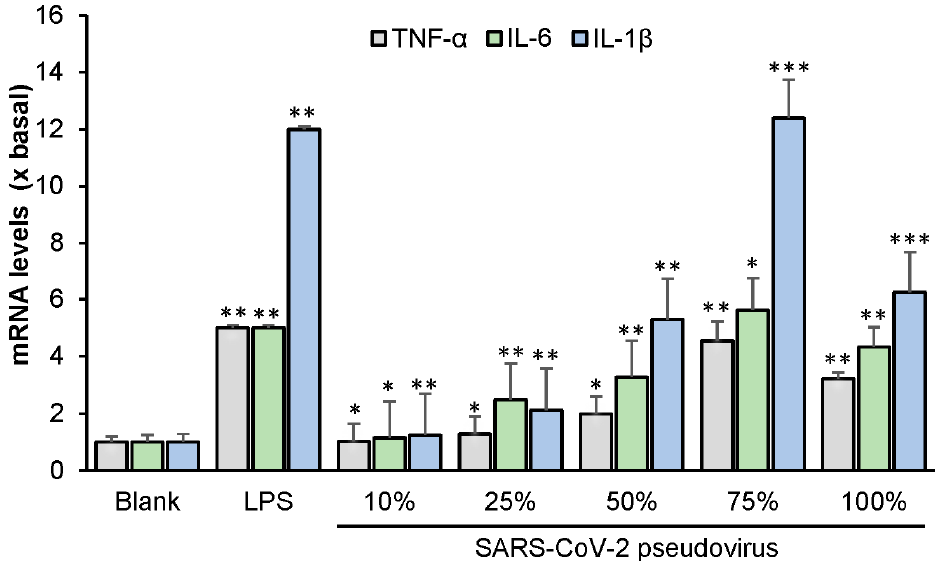
Figure 7. SARS-CoV-2 induces the expression of inflammatory cytokines in cultured macrophages. The mRNA levels of TNF- α , IL-6, and IL-1 β were measured by RT-PCR. The data indicate the mean ± SD ( n = 5) fold change against the blank group (x basal), and the asterisks indicate statistically significant differences such that * p <0.05, ** p < 0.01, *** p < 0.001 compared with the blank group.